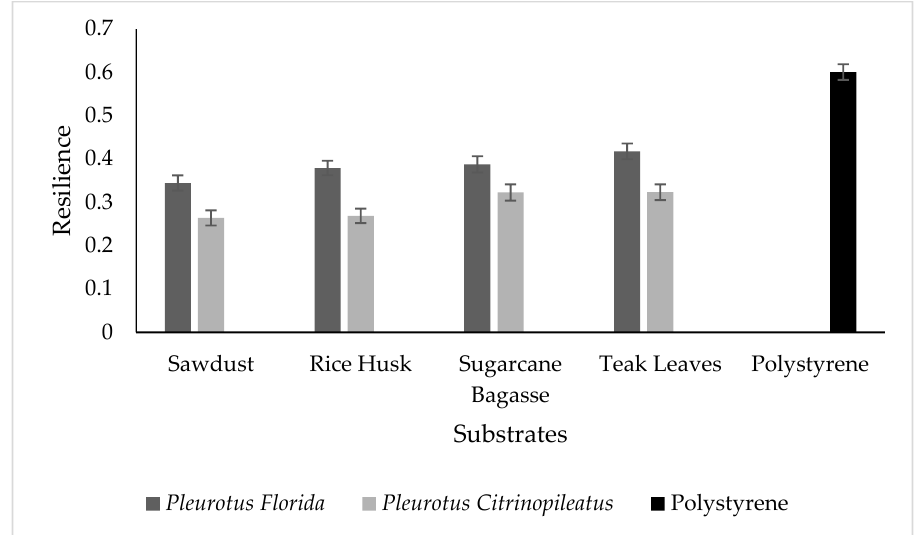
Figure 3. Resilience for different mushroom species of fungal foam in various types of substrates and polystyrene as the control.